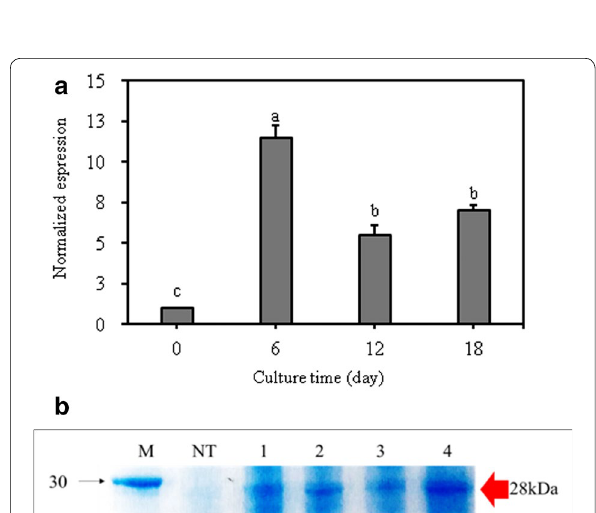
Fig. 5 Miraculin expression and protein analysis by SDS‑PAGE of transgenic callus harvested from bioreactor culture during culture period. a miraculin gene expression; b SDS‑PAGE analysis of miraculin SE protein. In A, the 0‑day time point served as a control. Data represent ± mean SE ( n 5), and different lowercase letters indicate statistically ± = significant differences ( P < 0.05; Duncan’s multiple range test). The value of control was taken as 1 to compare with transformed callus